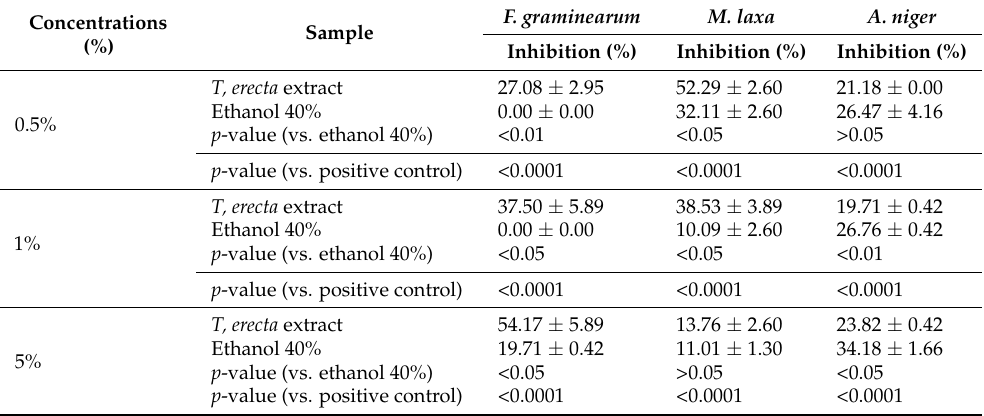
Figure 4. Antifungal activity for different concentrations of T. erecta extract (1–0.5%, 2–1%, 3–5%, 4–0%) and positive control against F. graminearum ( a ), M. laxa ( b ), and A. niger ( c ) strains. Table 6. Comparative qualitative evaluation of antifungal activity for different concentrations of T. erecta extract (0.5%, 1%, 5%) and similar solvent concentrations (40% ethanol) against phytopathogenic strains.